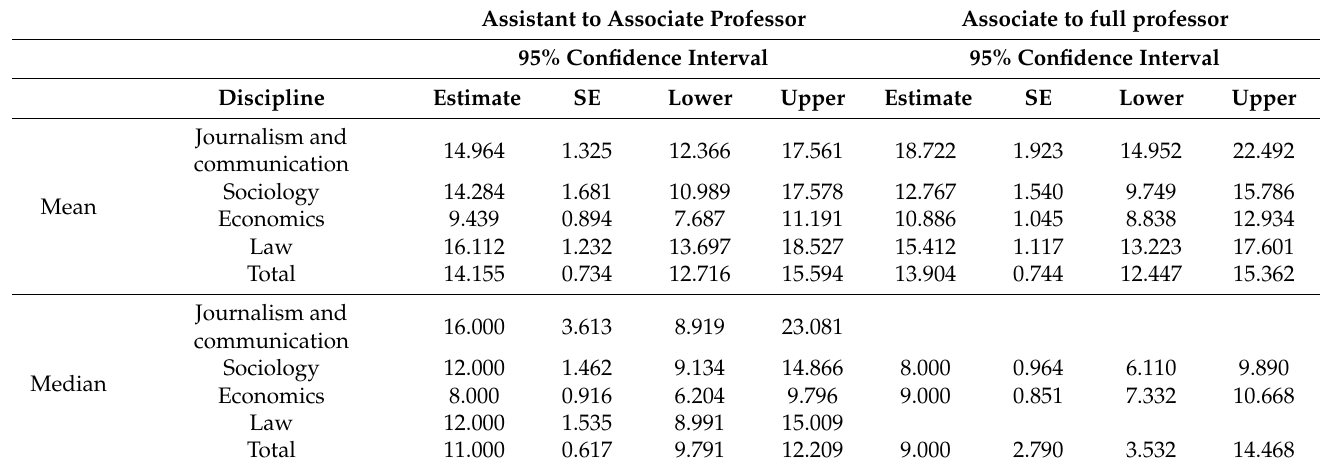
Table 2. Means and Medians of Promotion Duration of Different Disciplines.